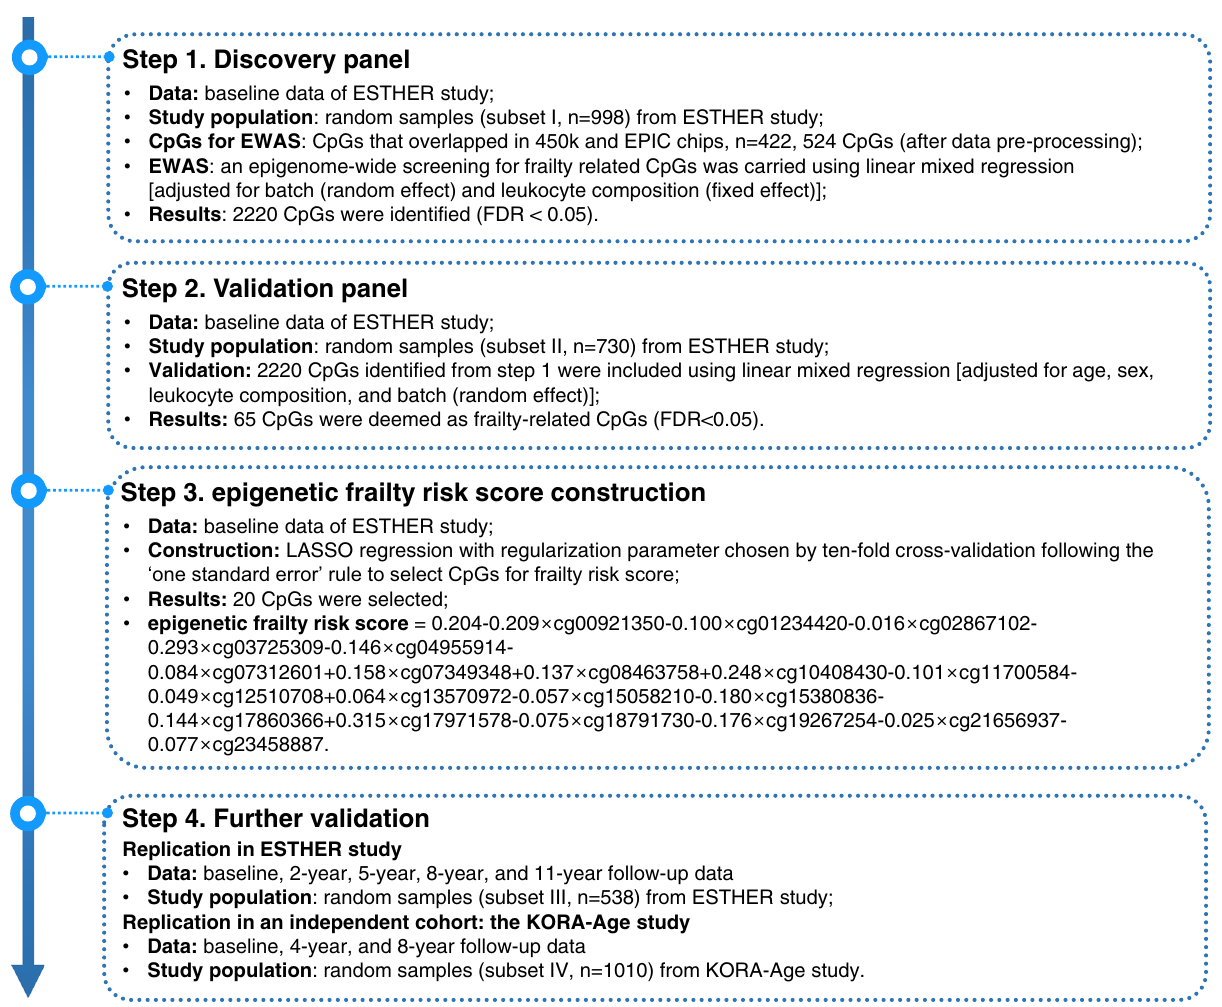
Fig. 4 | Study design and analysis fl owchart. FDR false discovery rate, EWAS epigenome-wide association